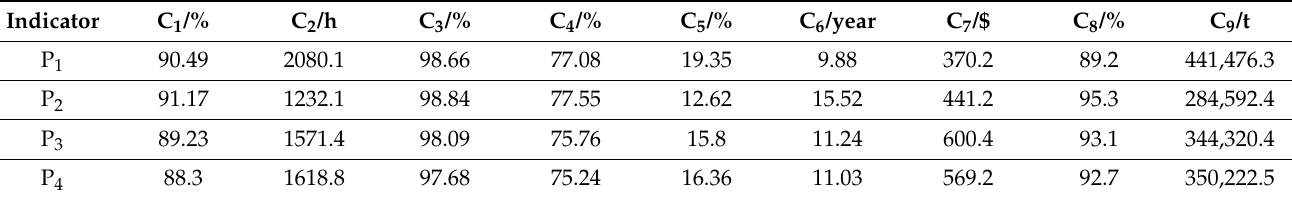
Table 3. Values of the quantitative indicators.